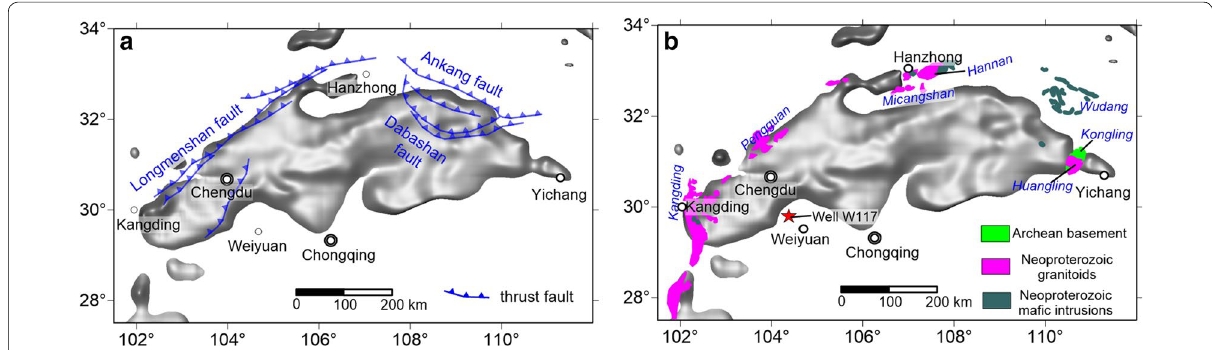
Fig. 6 Comparing our inverted susceptibility model with geological maps. a The main thrust faults around Sichuan Basin. b The distribution of the Neoproterozoic magmatic rocks. The base map is the inverted model represented by an iso-surface of susceptibility